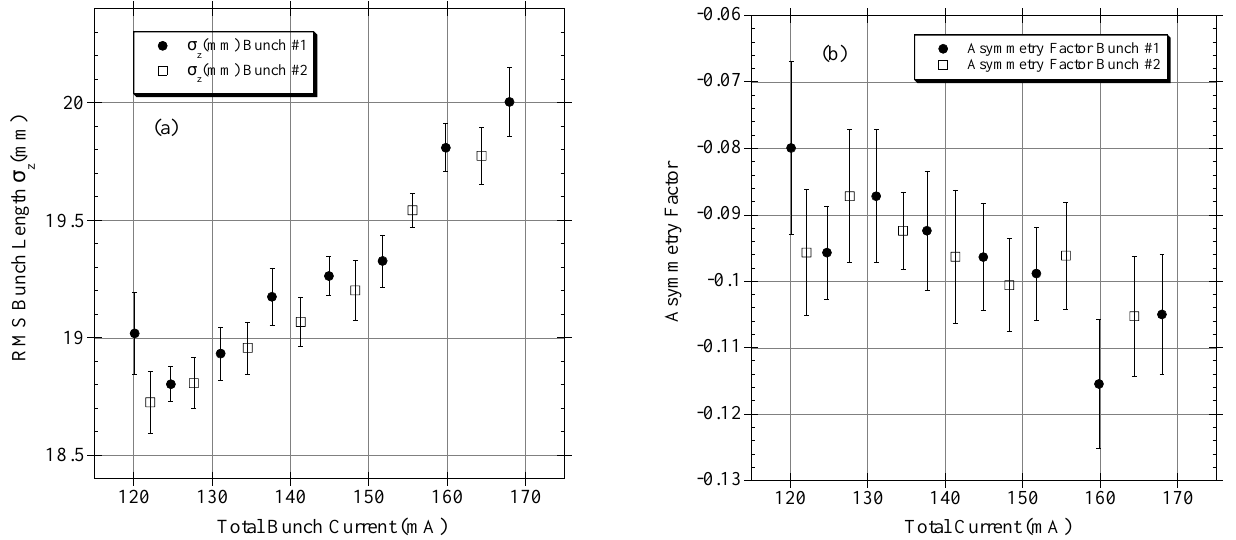
FIG. 11. (a) The electron bunch length and (b) asymmetry factor for bunches #1 and #2 as a function of current during high-energy colliding beams. There are 42 ns of spacing between each bunch during the measurement. TABLE II. The positron’s bunch length and asymmetry factor of the CESR bunch distribution as a function of pretzel amplitude with wiggler magnets open and closed. The horizontal pretzel amplitude units are computer units and the conversion to separation is approximately 1000 Cu (cid:1) 1 mr for one-half of the horizontal crossing angle at the interaction point. Horizontal pretzel